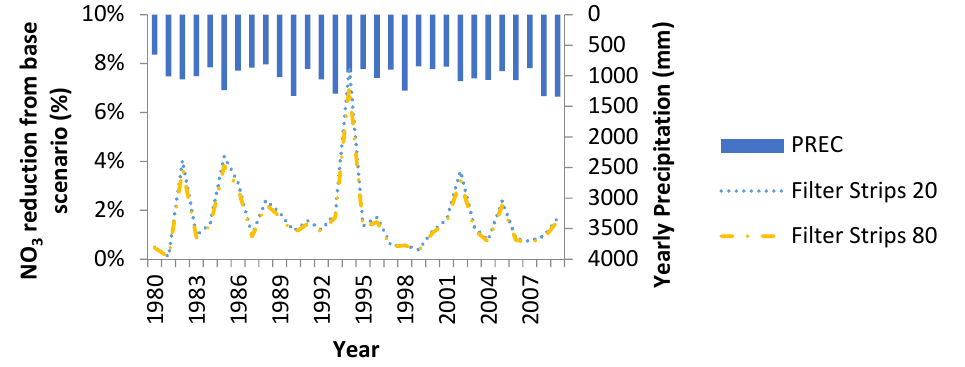
Figure 7. Nitrate load reduction in outlet flow for different filter strip configurations compared to base